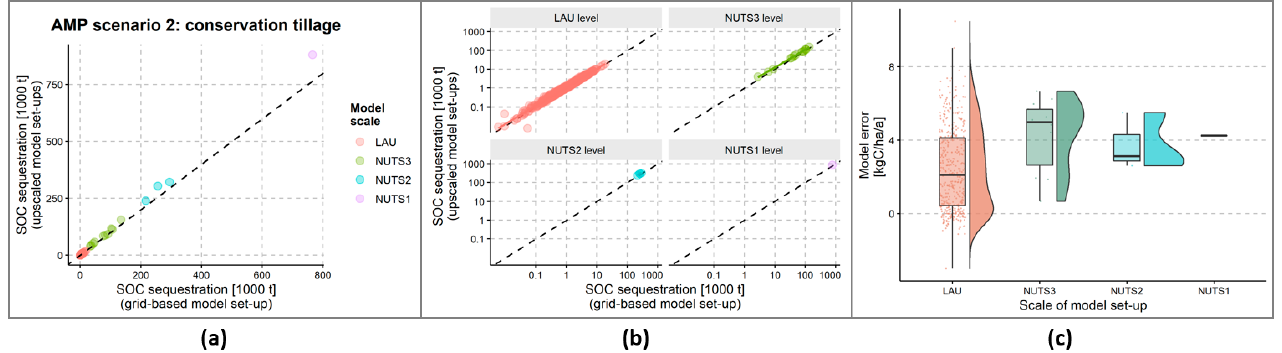
Figure 7. Carbon sequestration potential of the second alternative management practice (AMP-2; reducing carbon turnover conditions by increasing the use of conservation tillage) simulated with five different model set-ups. ( a ) Results of the grid-based reference simulation compared to the four upscaled model set-ups. ( b ) Same content as ( a ), but using a logarithmic scale for better visualization of carbon sequestration in smaller LAU regions. ( c ) Model errors in the assessment of AMP-2 for individual administrative units.